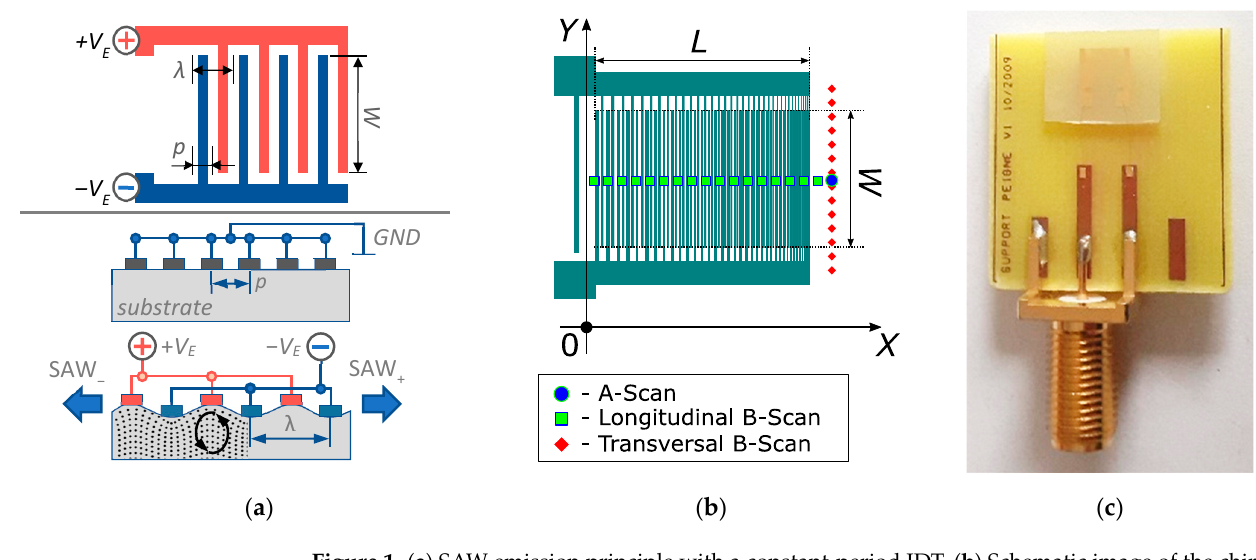
Figure 1. ( a ) SAW emission principle with a constant-period IDT. ( b ) Schematic image of the chirped IDT SAW emitter and locations of optical measurement points. ( c ) Photo of the chirped IDT used for thin film characterization.